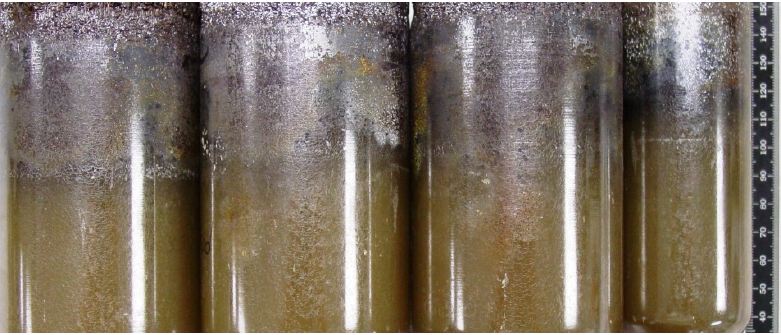
Figure 4. Seventy five-millimeter and 50-mm diameter <001>-oriented PIN-PMN-PT crystals grown by the Bridgman process (courtesy of TRS Technologies, Inc., State College, PA,